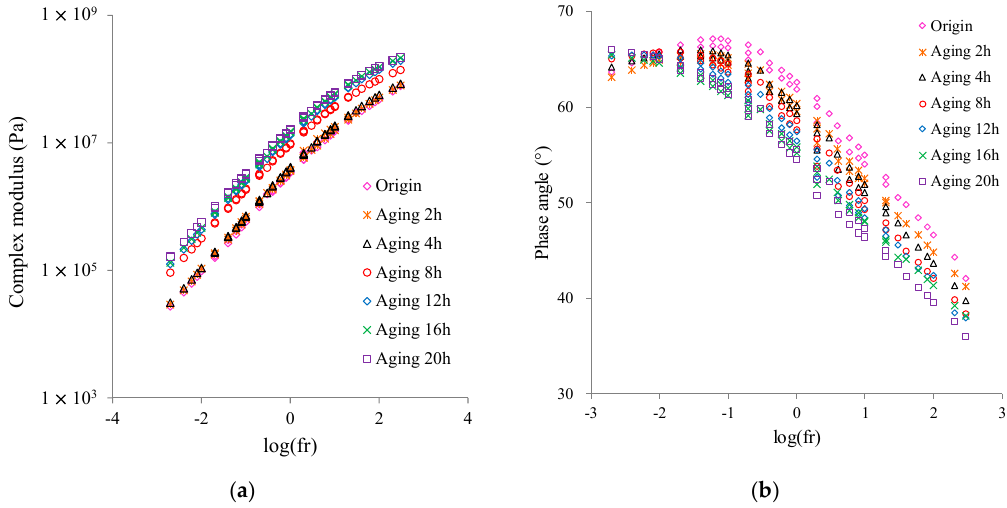
Figure 4. Master-curve of the mastics with filler content of 80% after different aging times: ( a ) complex modulus; ( b ) phase angle. Table 4. CAM model fitting results of master-curves from mastics with different aging times.